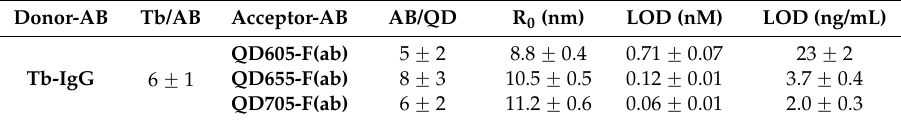
Table 1. Overview of Tb and QD AB conjugation ratios, Förster distances R 0 , and limits of detection (LOD) of PSA immunoassays using the three different FRET-pairs. Donor-AB Tb/AB Acceptor-AB AB/QD